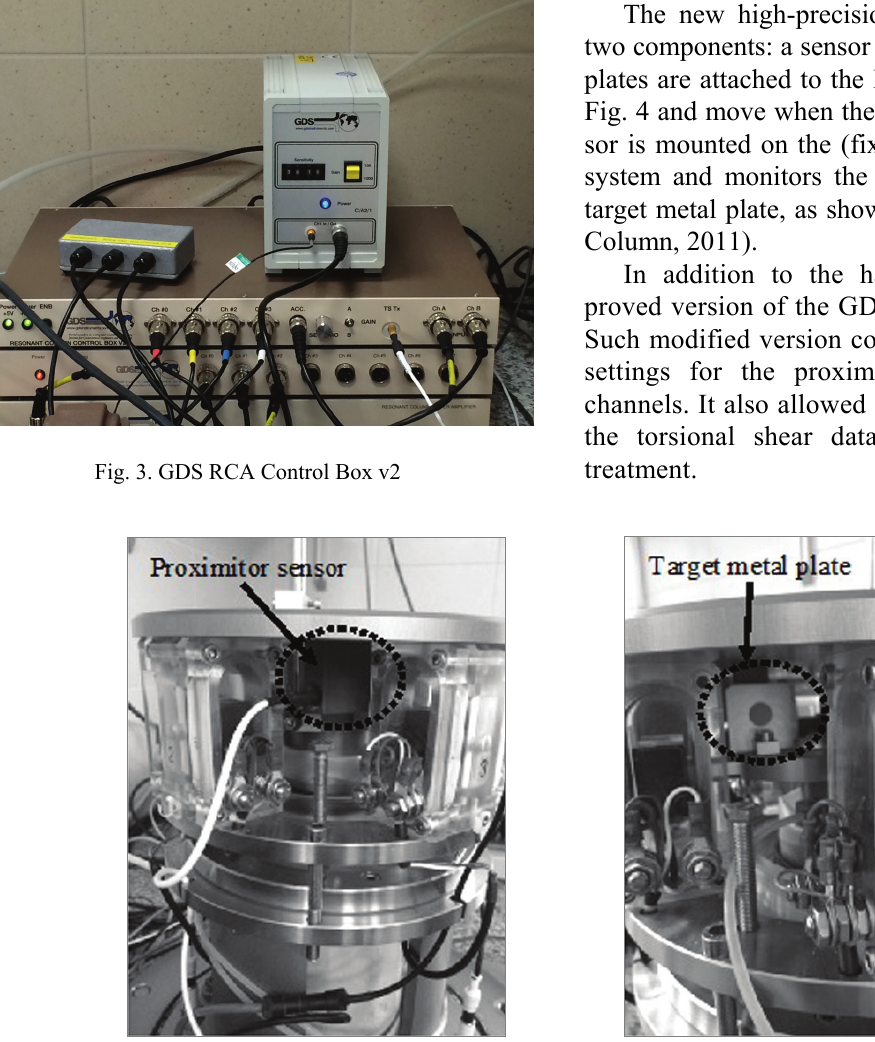
Fig. 4. Location of proximitor on the drive system